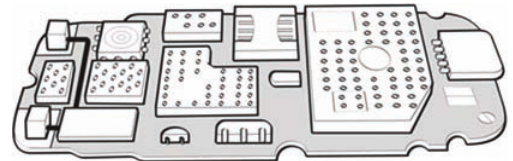
F 31: Schematic of a handset phone including two ground plane boosters located at the short edge of the PCB.